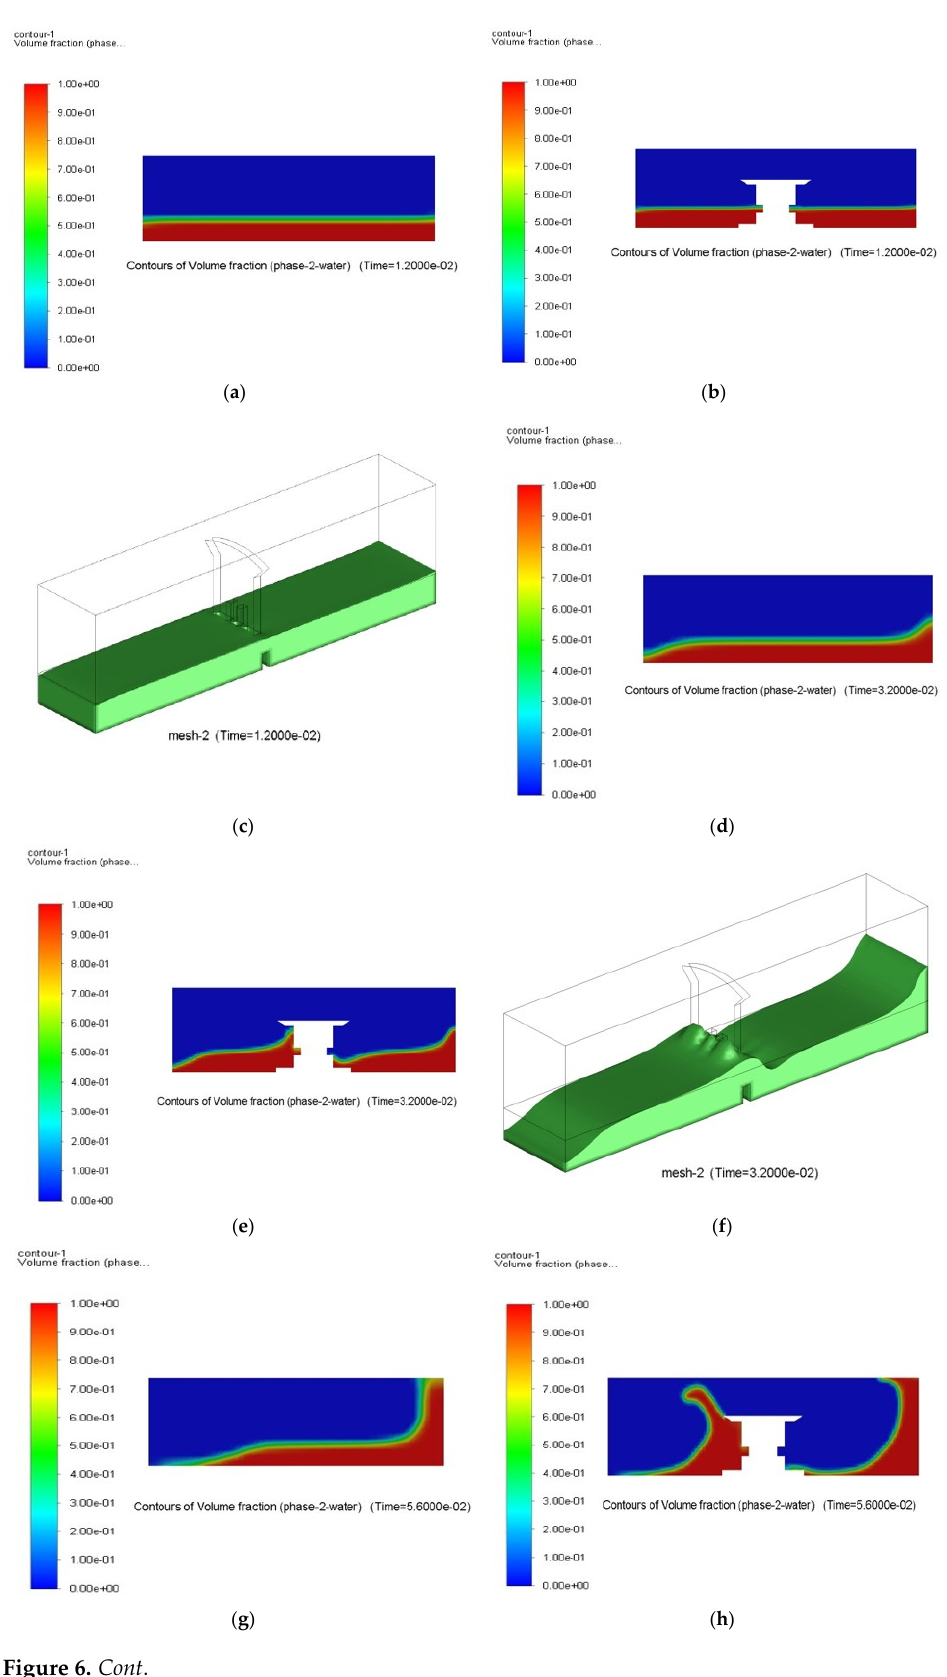
3.2. Comparison of Sloshing Pressure between Unbaffled and Baffled Tanks under 25% Filling On the other hand, the illustrative comparison of the contour of volume fraction re- sults is shown in Figure 6. The volume fraction results at different periods under three cases, unbaffled tank in Figure 6a, 6d, 6g, and 6j, baffled tank with imperforate baffle in Figure 6b, 6e, 6h, and 6k, and baffled tank with perforated baffle as shown in Figure 6c, 6f, 6i, and 6l, respectively, are represented to show the various performance of each case on the sloshing pressure at different tank wall’s locations.